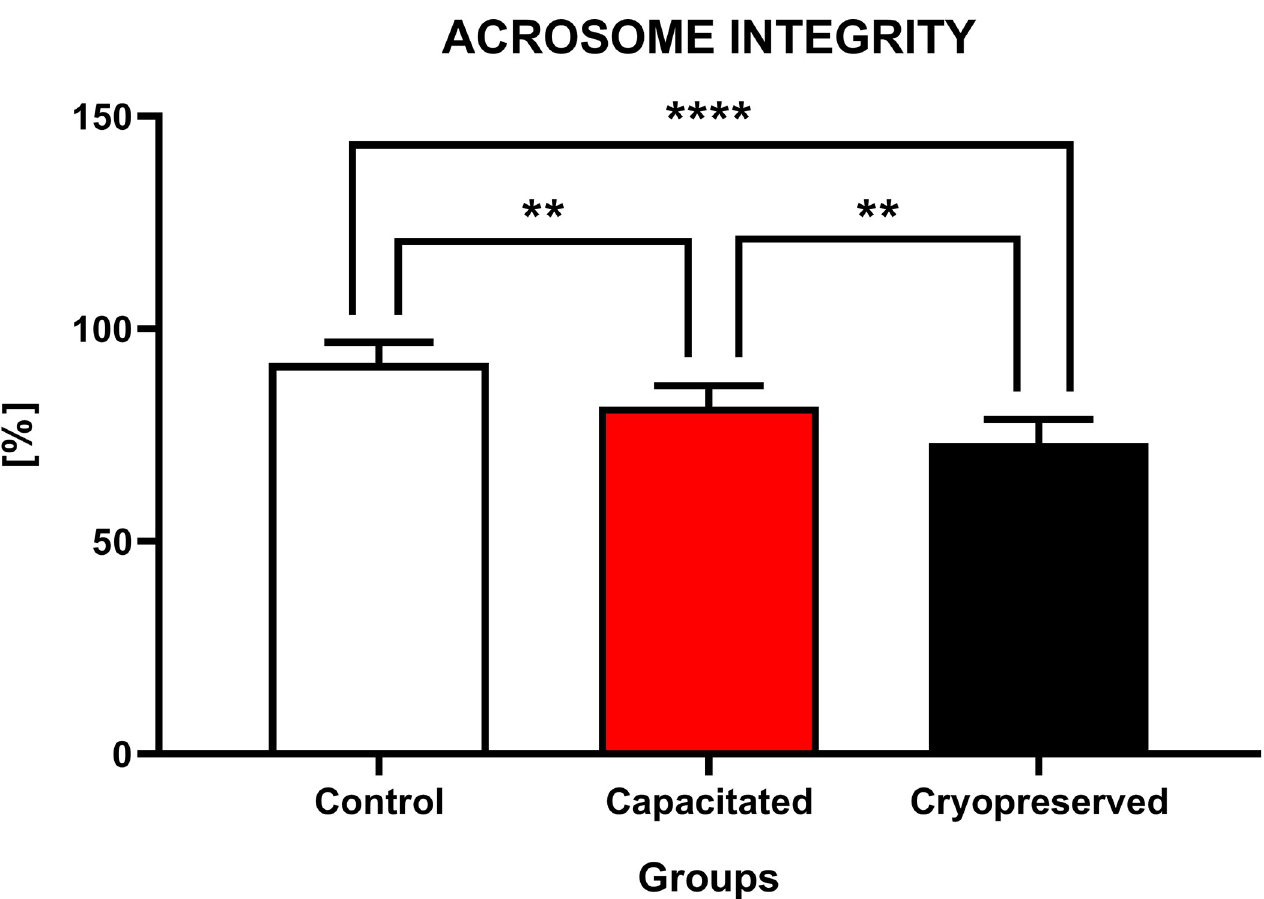
Fig 6. Acrosome integrity of non-capacitated, in vitro capacitated and cryopreserved bovine spermatozoa. Each bar represented the proportion of spermatozoa (%) with intact acrosome by comparing all groups with each other ( ± SD). The level of significance was set at � P < 0.05; �� P < 0.01; ��� P < 0.001; ���� P <